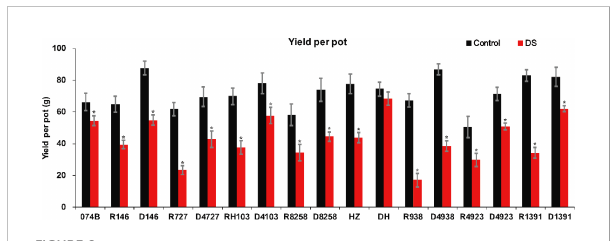
FIGURE 2 Rice yield per pot for 074B, restorer lines, and hybrid progeny. DS represents drought stress treatment. Error bars denote standard deviations ( n = 3); “ * ” stands for signi fi cance between drought stress and control condition in the same cultivar (p ≤